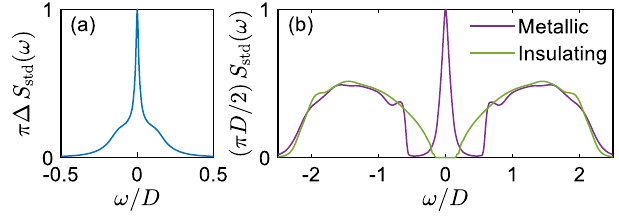
FIG. 14. Standard (2p) spectral functions S (a) the AIM chosen for Figs. 8 and 13 and (b) the DMFT solutions of the HM chosen for Fig. 15. Here, S by the adaptive broadening scheme of Ref.